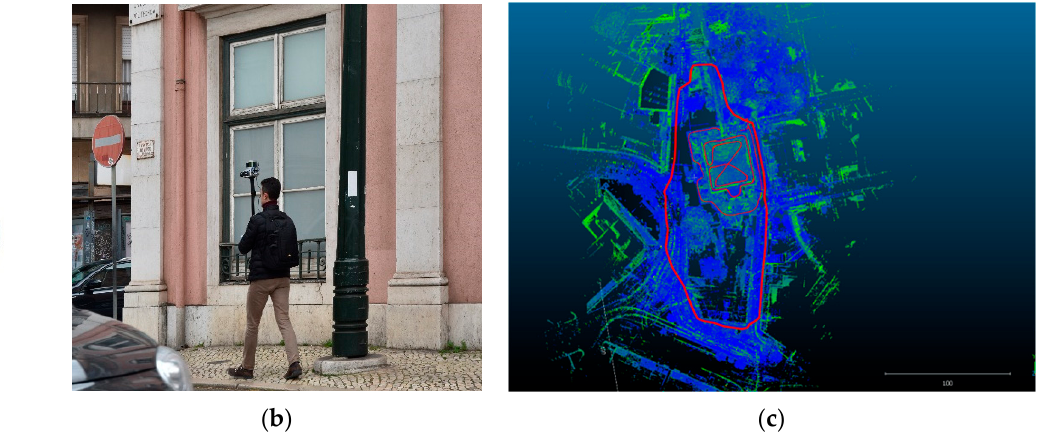
Table 2. Parameters setting for the mapping system (Kaarta Stencil 2–16).